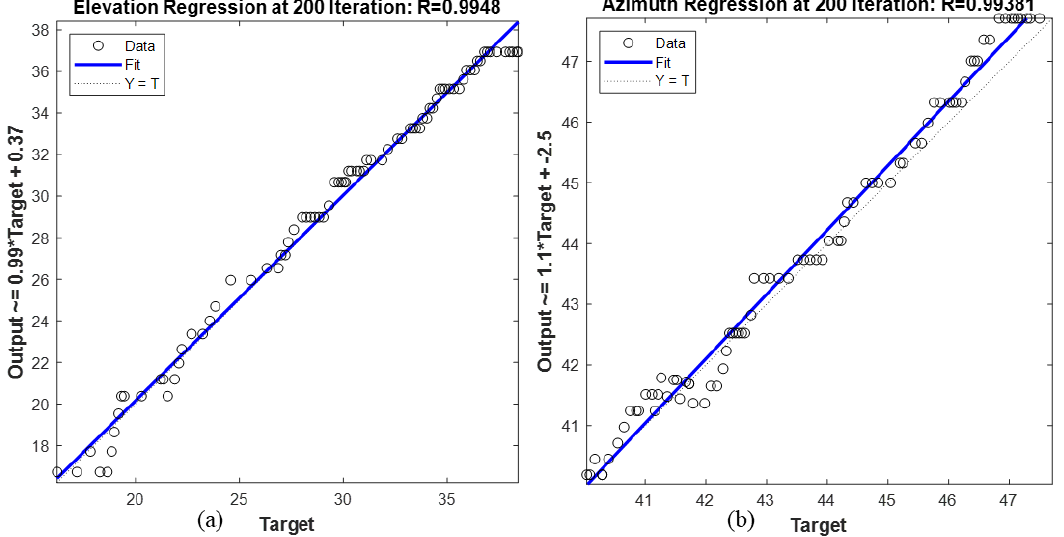
Figure 7. Lightning mapping regression performance at 200 iterations: ( a ) elevation regression performance; ( b ) azimuth regression performance.